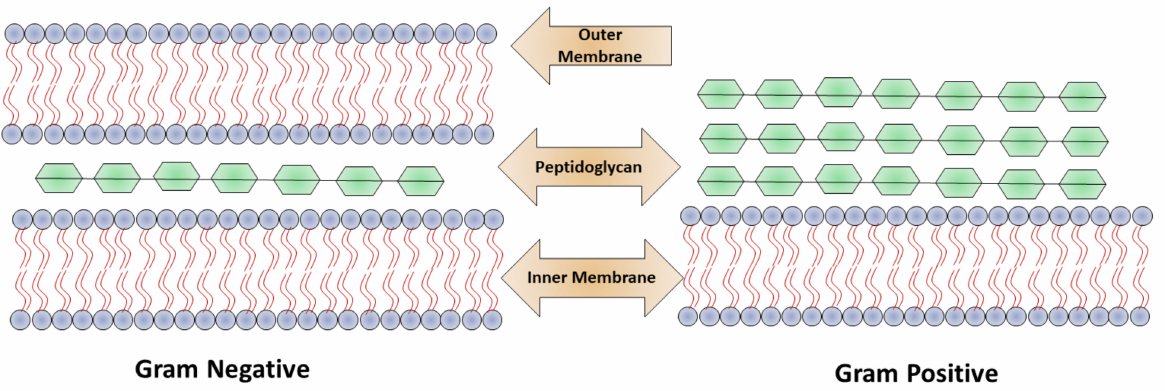
Figure 1. Structural difference between Gram-positive and Gram-negative